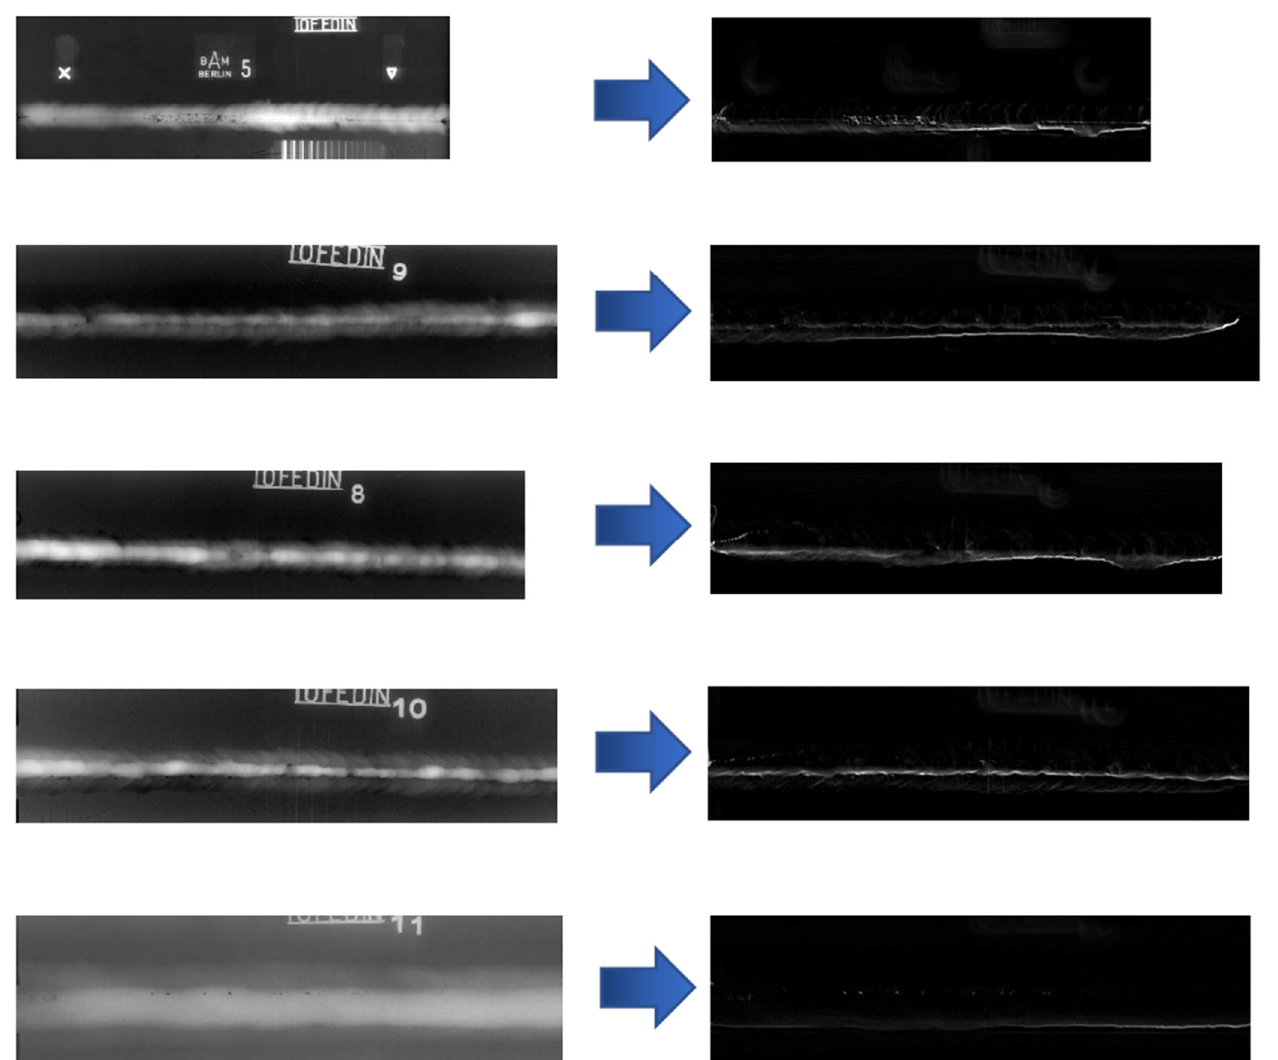
Figure 4. Results of preprocessing images of welded joints radiographic inspection.